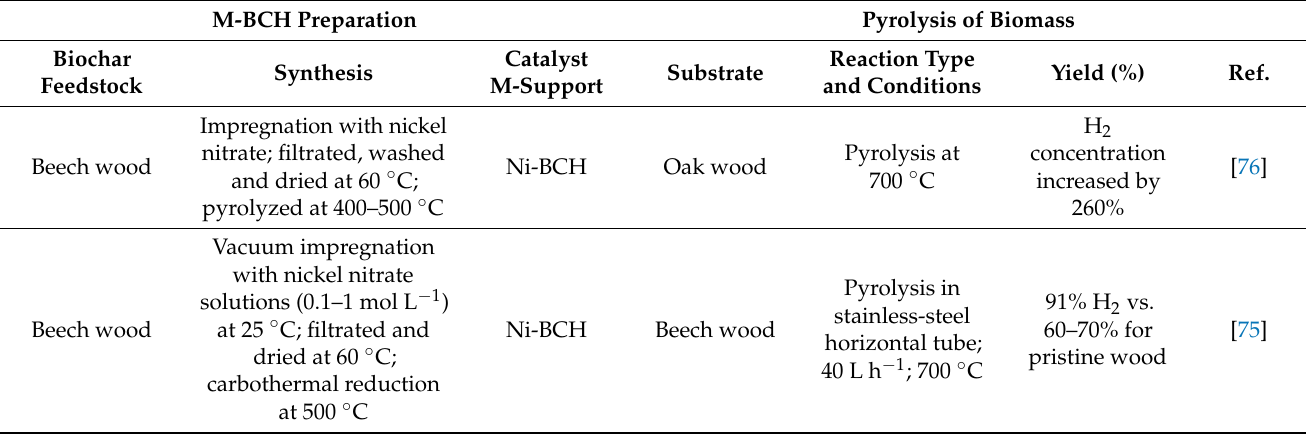
Table 4. Metal-supported biochar-based catalysts used in the pyrolysis of biomass